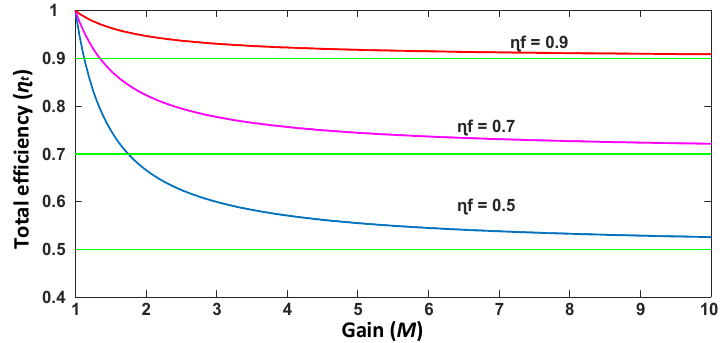
Figure 6. Total efficiency behavior with respect to gain.